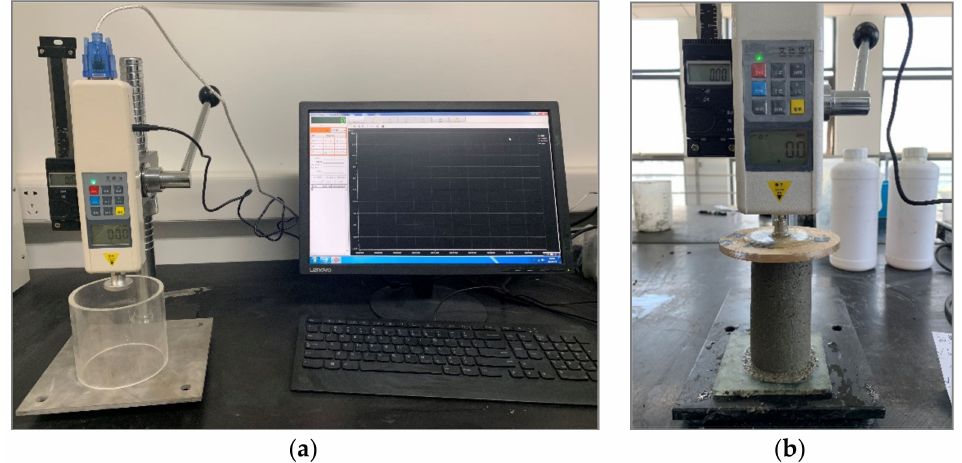
Figure 7. ( a ) The green strength test instrument for testing and recording and ( b ) the sample under